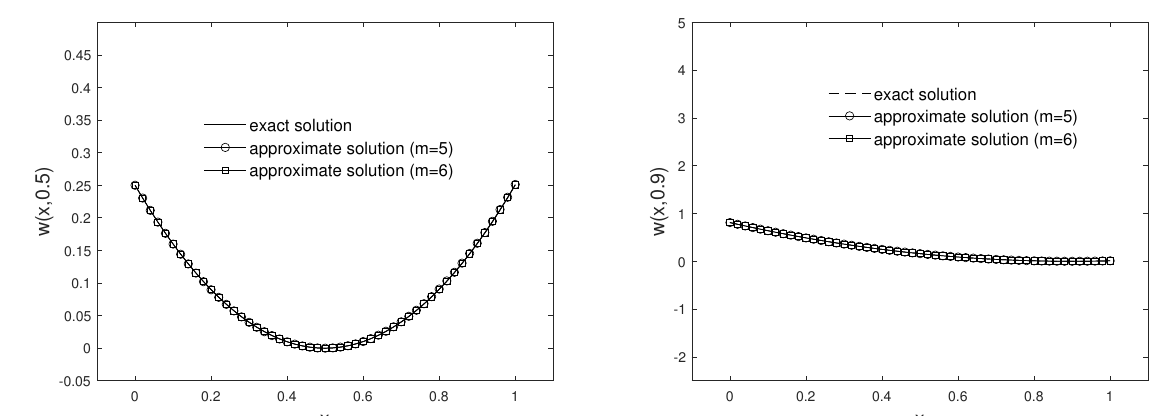
Figure 8. Plot of exact and approximate solutions at time t = 0.5 and t = 0.9 taking θ = 1/2, r = 5, J = 2 and δ t = ( 0.1 ) /2 m for Example 2.